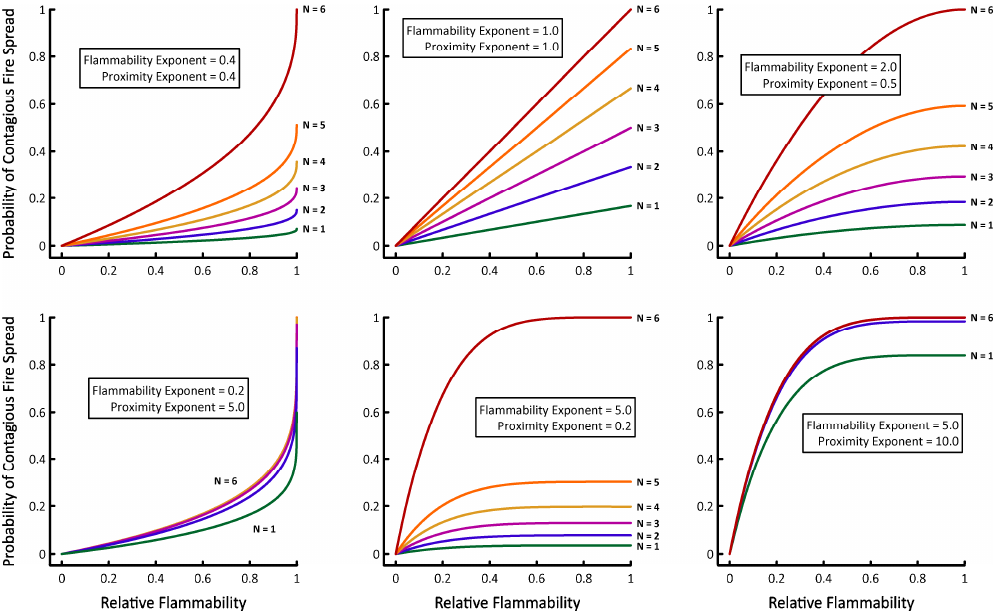
Figure 2. Six examples of how the probability of contagious fire spread changes as a function of a cell’s relative flammability, and its number of burning neighbors (N).